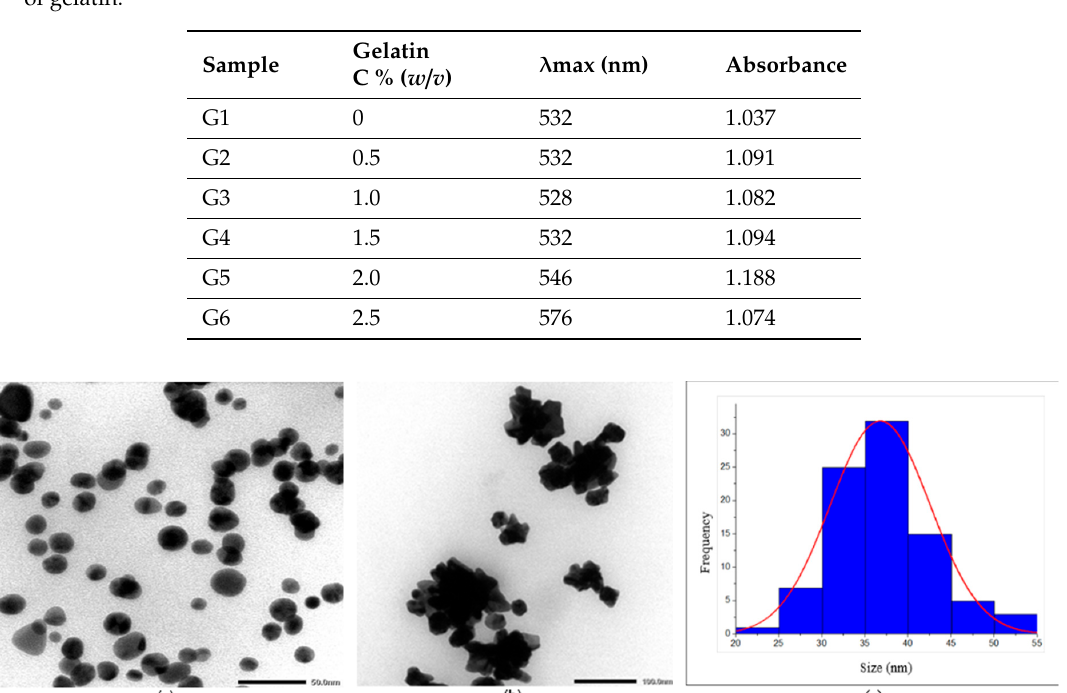
Figure 1. UV-Vis adsorption spectra of branched gold nanoparticles (AuNPs) synthesized by gelatin with different concentrations of ( a ) 0, ( b ) 0.5, ( c ) 1.0, ( d ) 1.5, ( e ) 2.0, ( f ) 2.5% (w/v). Table 1. UV-Vis results of branched AuNPs synthesized by gelatin with di ff erent concentrations of gelatin.